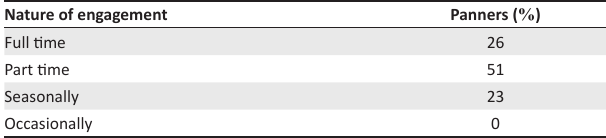
TABLE 2: Panners’ nature of engagement.